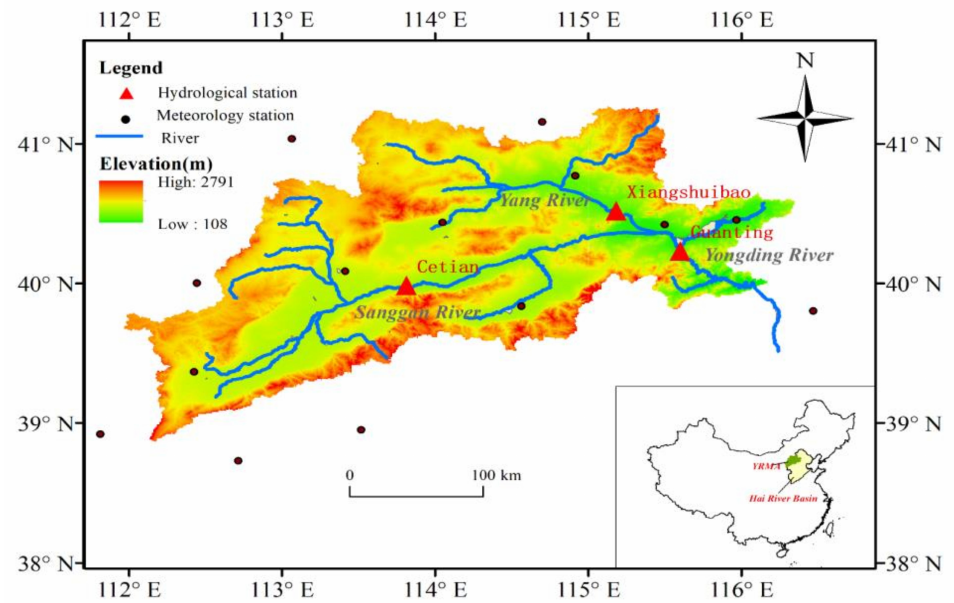
Figure 1. Location of meteorological and hydrological stations in the Yongding River mountain